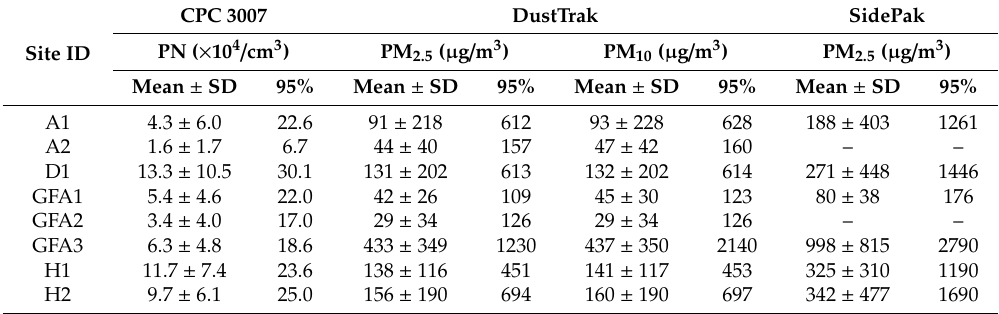
Table 4. Indoor particle number and mass concentrations (mean ± SD and 95%) during the winter campaign.